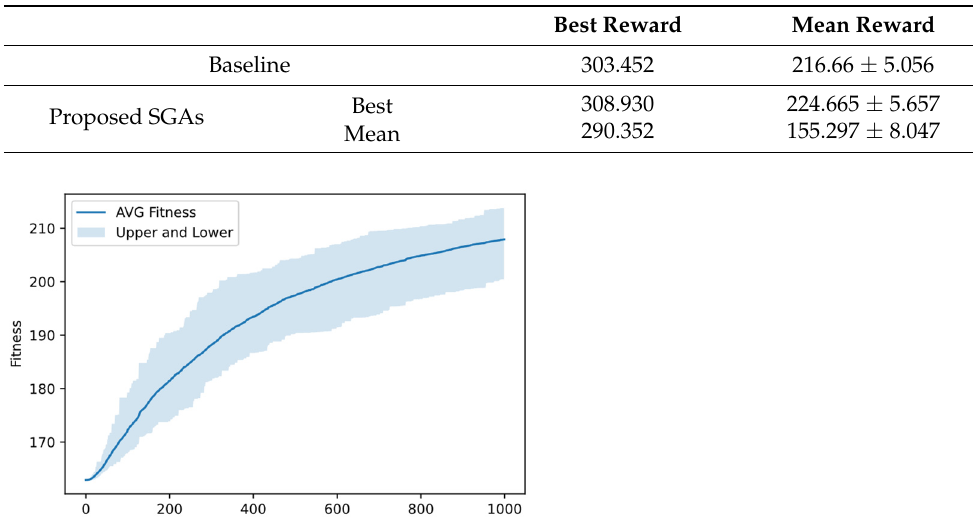
Table 6. Simulation performance of the baseline and the proposed SGAs for the lunar lander problem (from 30 runs).